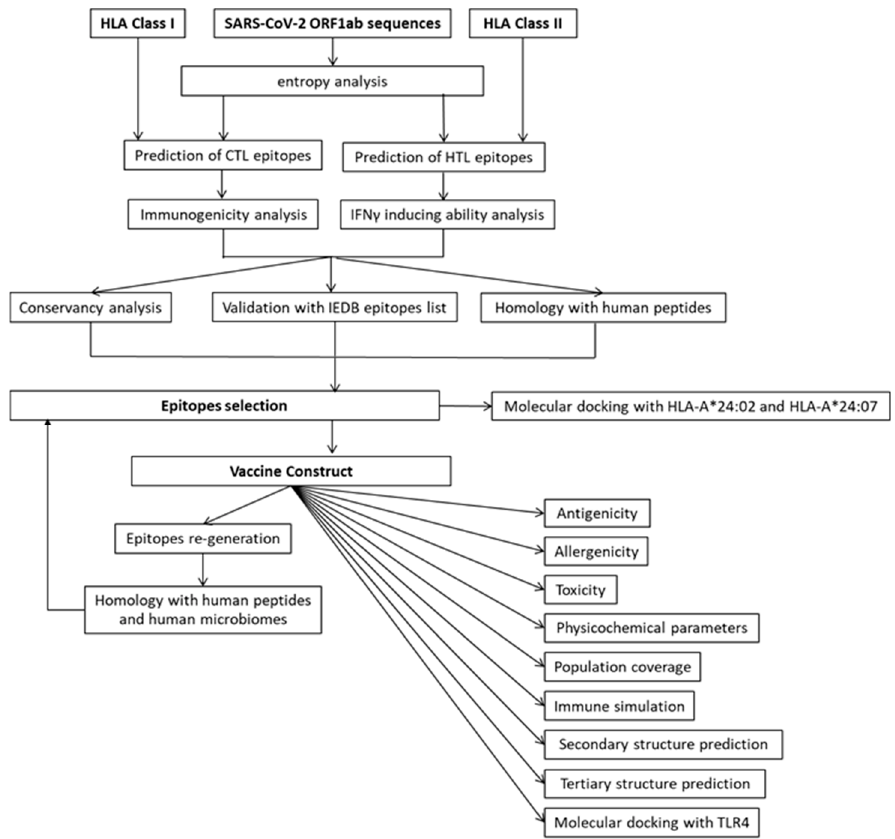
Figure 1. Flowchart indicating the immunoinformatics methods used in this study to identify the CTL and HTL epitopes from SARS-CoV-2 ORF1ab